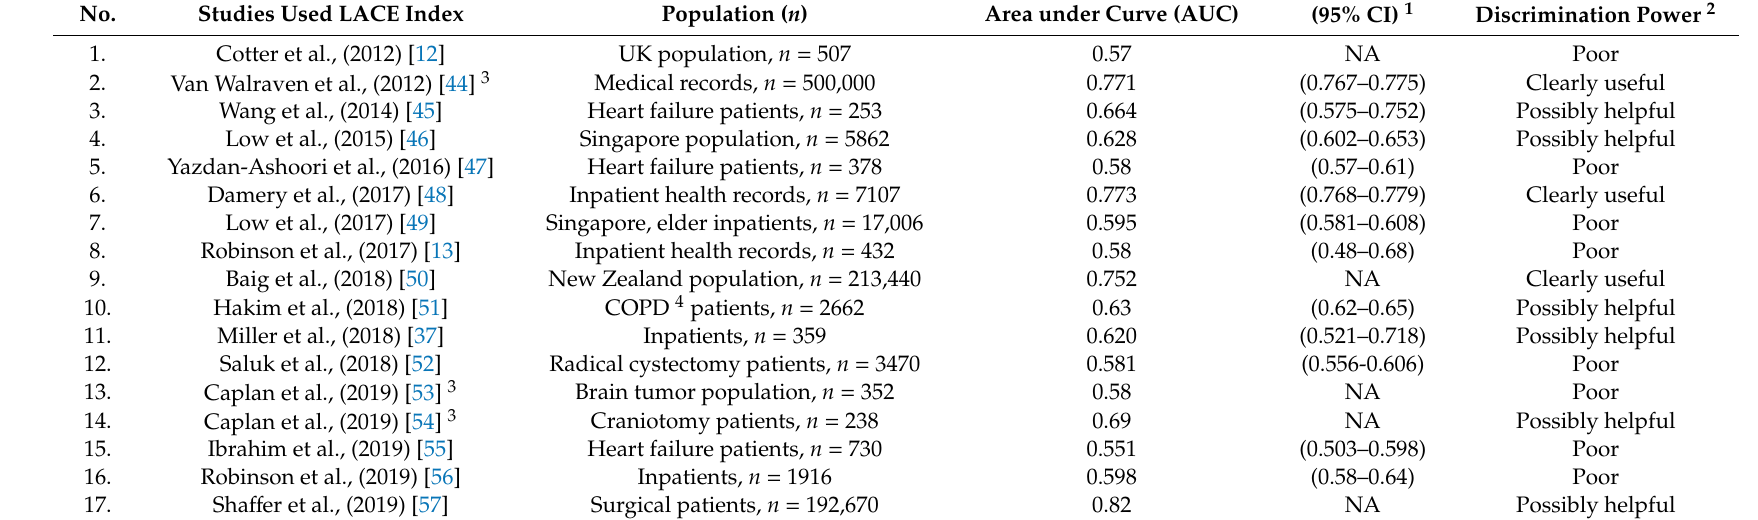
Table A3. Summary of previous studies which used the LACE index predictive model for readmission of di ff erent populations. Ordered according to year of